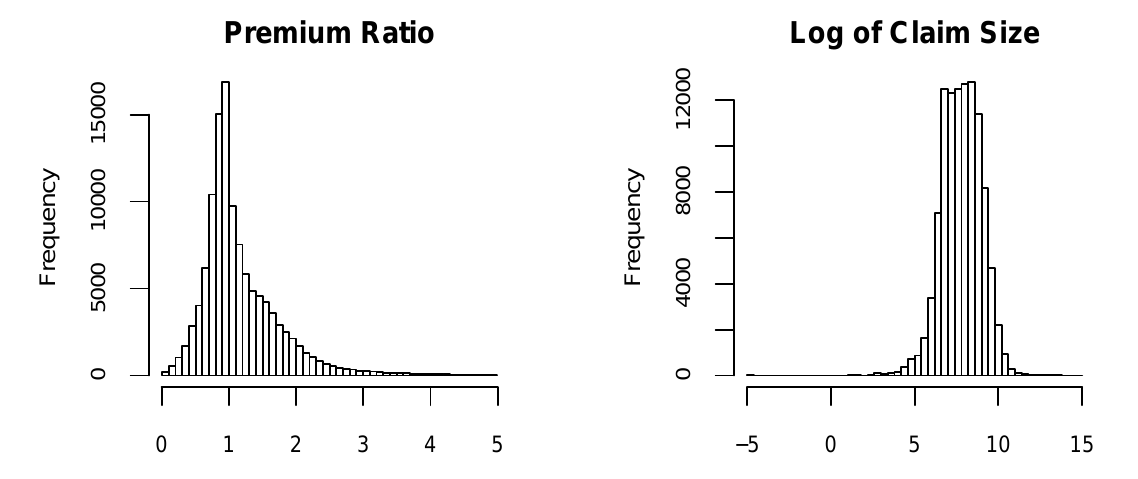
Figure 2. Histograms of premium ratio and log of claim size.